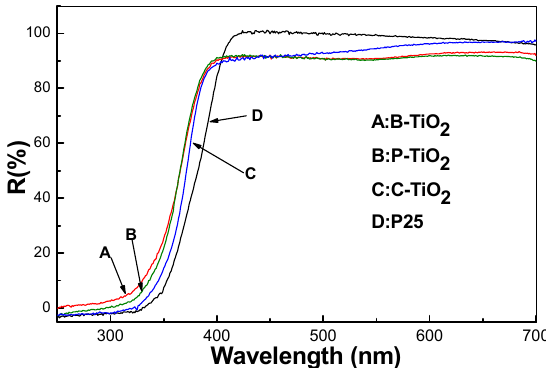
Figure 11. Diffusion reflectance spectra of the mesoporous TiO 2 hollow spheres ( A : B-TiO 2 , B : P-TiO 2 , C : C-TiO 2 , and the commercial P25 titania D .